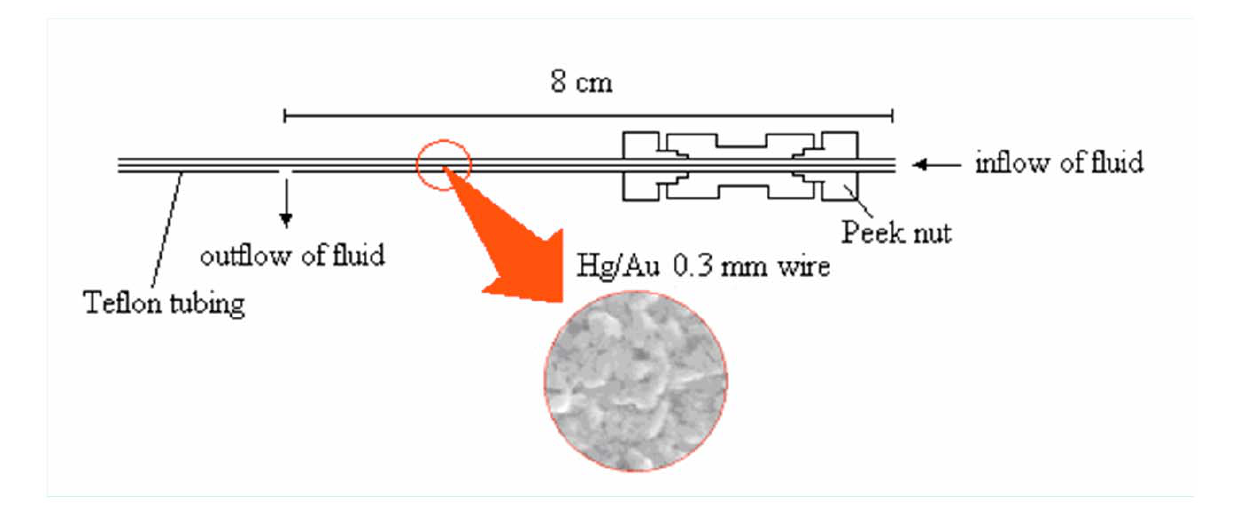
Figure 11. Diagram of a mercury-modified gold-wire flow-through electrolysis